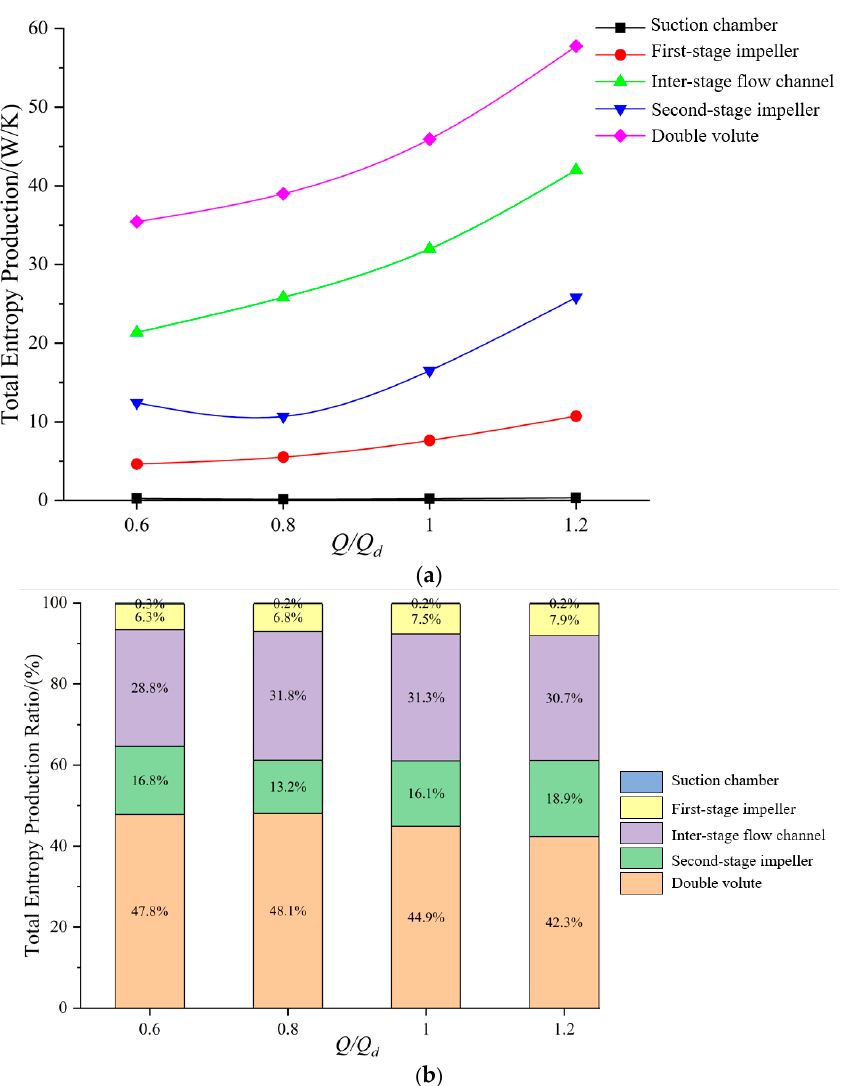
Figure 13. Di ff erent representations of entropy production under di ff erent fl ow rates include ( a ) Figure 13. Different representations of entropy production under different flow rates include energy loss distribution and ( b ) total entropy production rate distribution. ( a ) energy loss distribution and ( b ) total entropy production rate